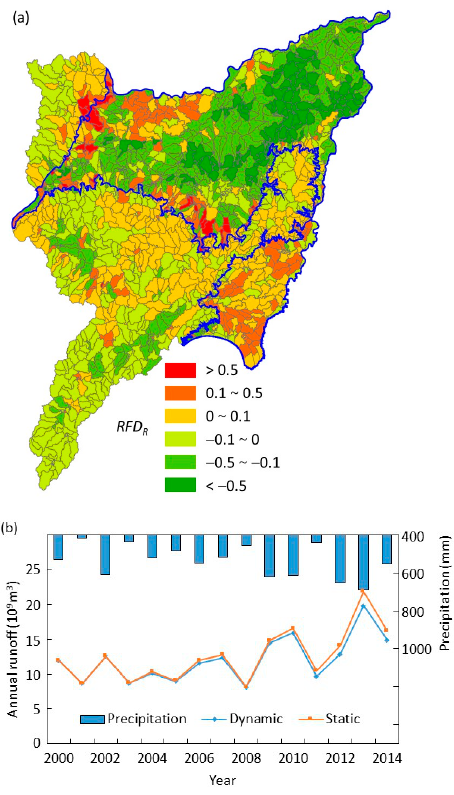
Figure 10. Spatial and temporal differences in runoff yield between the dynamic mode and the static mode from 2000 to 2014. ( a ) The relative difference in the average annual runoff (RFDR) on the sub-watershed scale and ( b ) a comparison of annual runoff processes in the whole region. The precipitation is the weighted average value of the rainfall station control